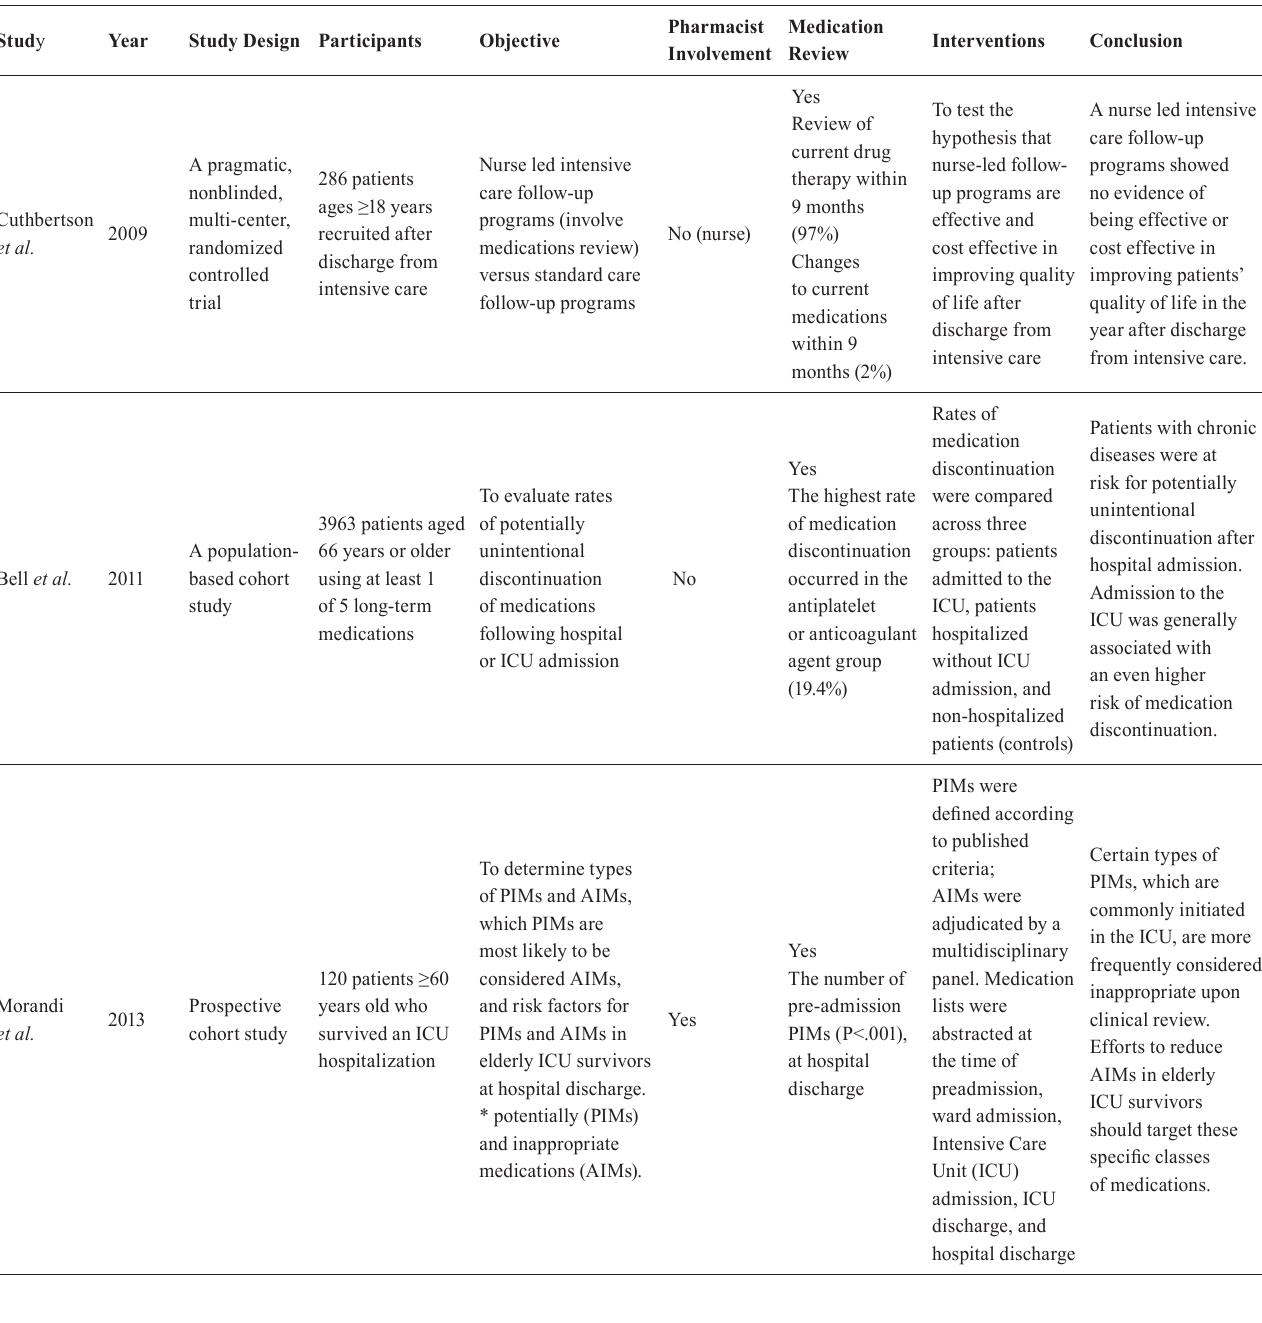
TABLE I - S ummary of the literature related to pharmacist contributions or medication review for post-ICU survivors